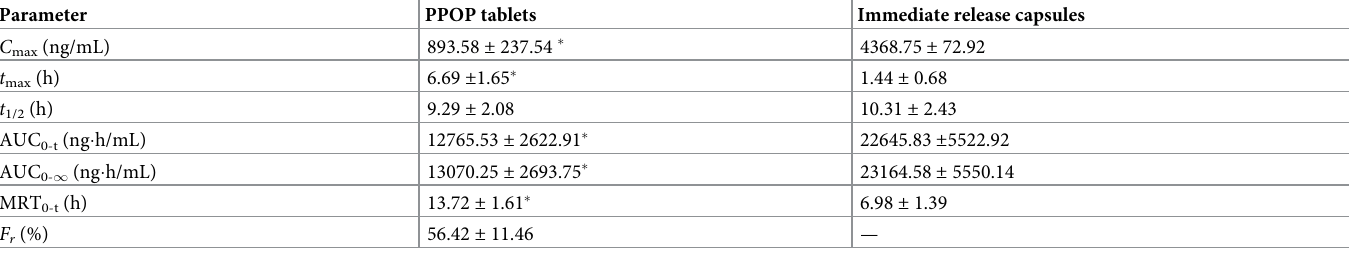
Table 4. Pharmacokinetic parameters of topiramate (TPM) in beagle dogs after a single dose oral administration of TPM push-pull osmotic pump (PPOP) tablets and immediate release capsules (n = 6).